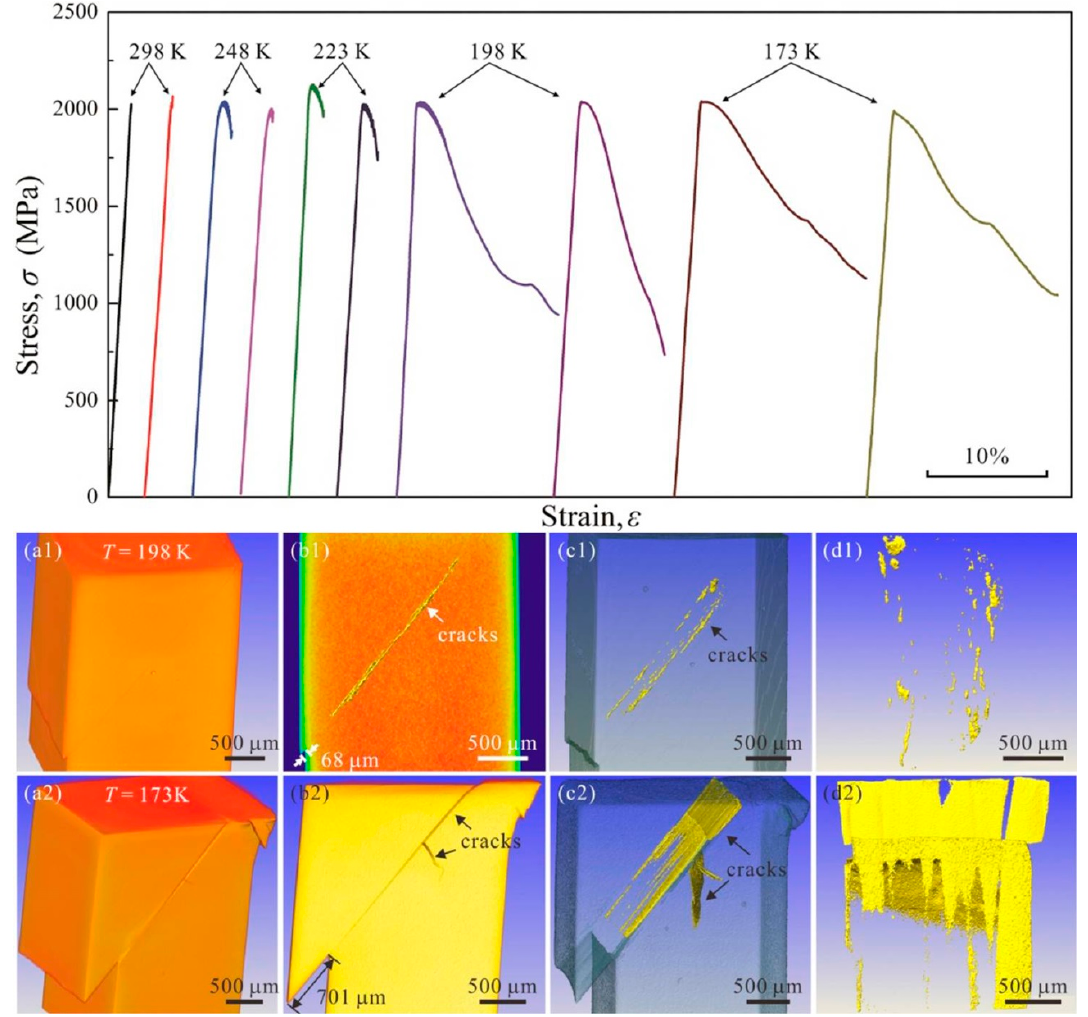
Figure 4. Typical engineering stress–strain curves under compression at temperatures from 298 K to 173 K showing the influence of testing temperature on the stress-strain behavior of Ti32.8Zr30.2Ni5.3Cu9Be22.7 metallic glass and the XRT results corresponding to the samples at 198 K ( a1 – d1 ) and 173 K ( a2 – d2 ). ( a1 – a2 ) the global 3D volume renderings of the samples. ( b1 – b2 ) 2D slice or cross-section showing the internal cracks well located in the shear band plane. ( c1 – c2 ) and ( d1 – d2 ) 3D extracted internal cracks observed from different perspectives. The XRT volume renderings together with the 3D internal cracks show the temperature effect on the deformation of the MG sample. [115].